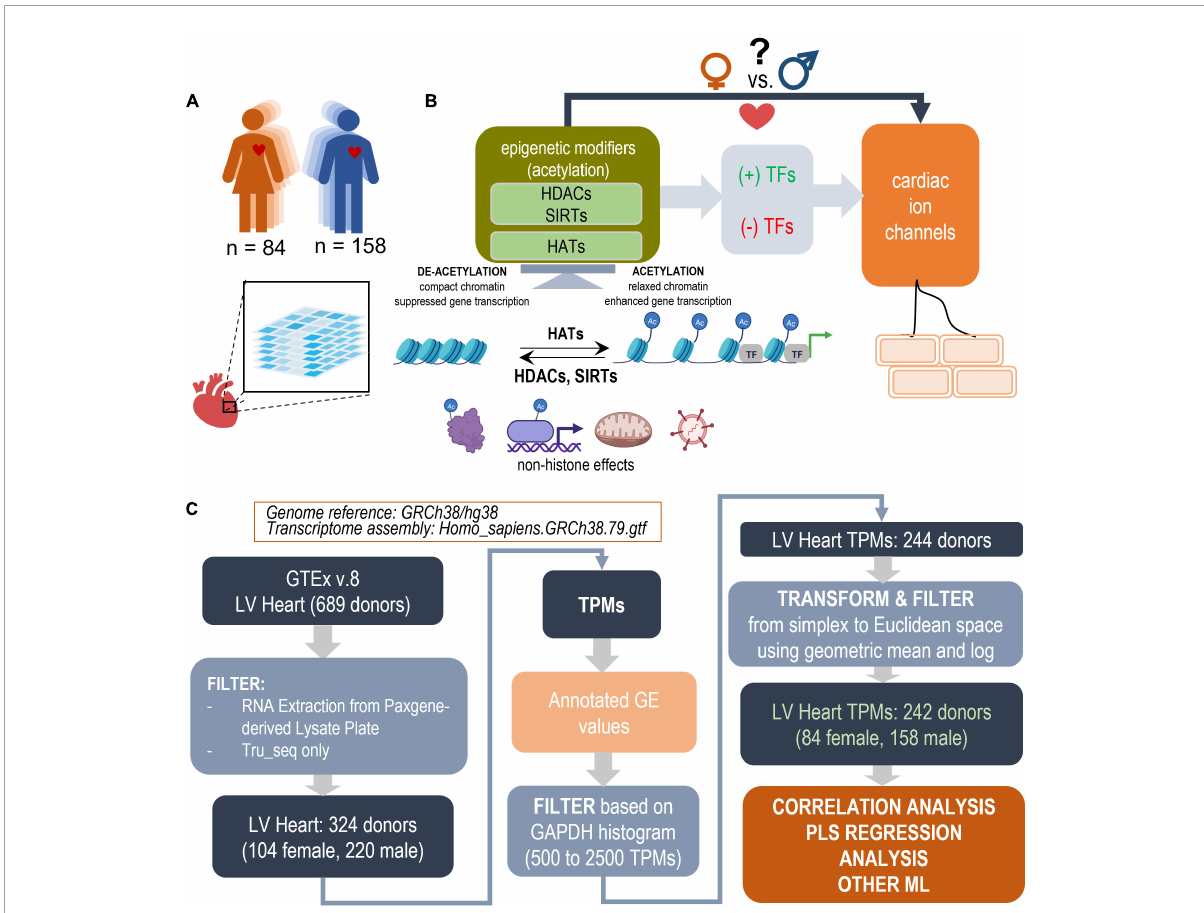
FIGURE1 Study design outline and processing steps. Using the GTEx database to inform PLS regression models of the effects of acetylation modifiers (HDACs, SIRTs, HATs) on cardiac ion channels via key TFs in the adult male and female left ventricle (LV). (A) LV bulk RNAseq data from 84 female and 158 male adults were used from the GTEx dataset. (B) The performed analysis examines how the balance of HDACs, SIRTs, and HATs may affect cardiac ion channel transcription in a sex-dependent manner. HDACs and SIRTs counter the action of HATs, which acetylate chromatin thus increasing its accessibility for key cardiac TFs to act on genes of interest; they also have non-histone actions, including acetylation of cytoplasmic proteins, direct binding to, acetylation of transcription factors, effects on oxidative stress, anti-viral action etc. HDACs, SIRTs, and HATs negatively or positively regulate the effects of TFs and consequently change the expression of cardiac ion channels. (C) Parts of panel B were generated using Biorender.com. Processing pipeline: Starting with 689 donors in the GTEx v.8 dataset, after filtering and transformations, 242 donors were used for correlation and PLS regression analysis. The processing steps include TPM filtering based on GAPDH levels to yield similar normal distributions and a log-ratio transformation from simplex to Euclidian